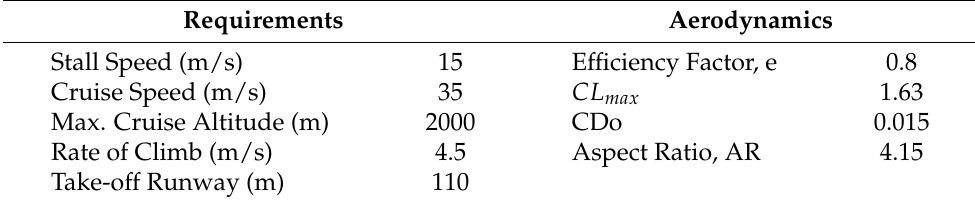
Table 2. General Data and Top Level